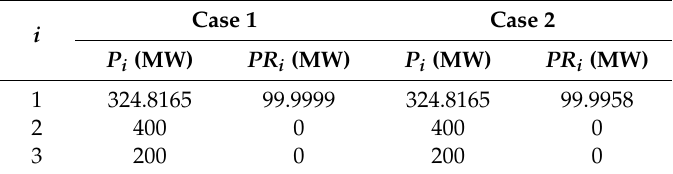
Table A3. Optimal solutions for the three-unit system obtained by HLN-EF.